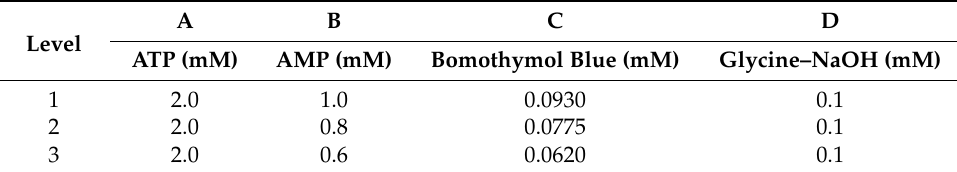
Table 3. Factors and levels affecting Adk activity assay with the constants of A and D.